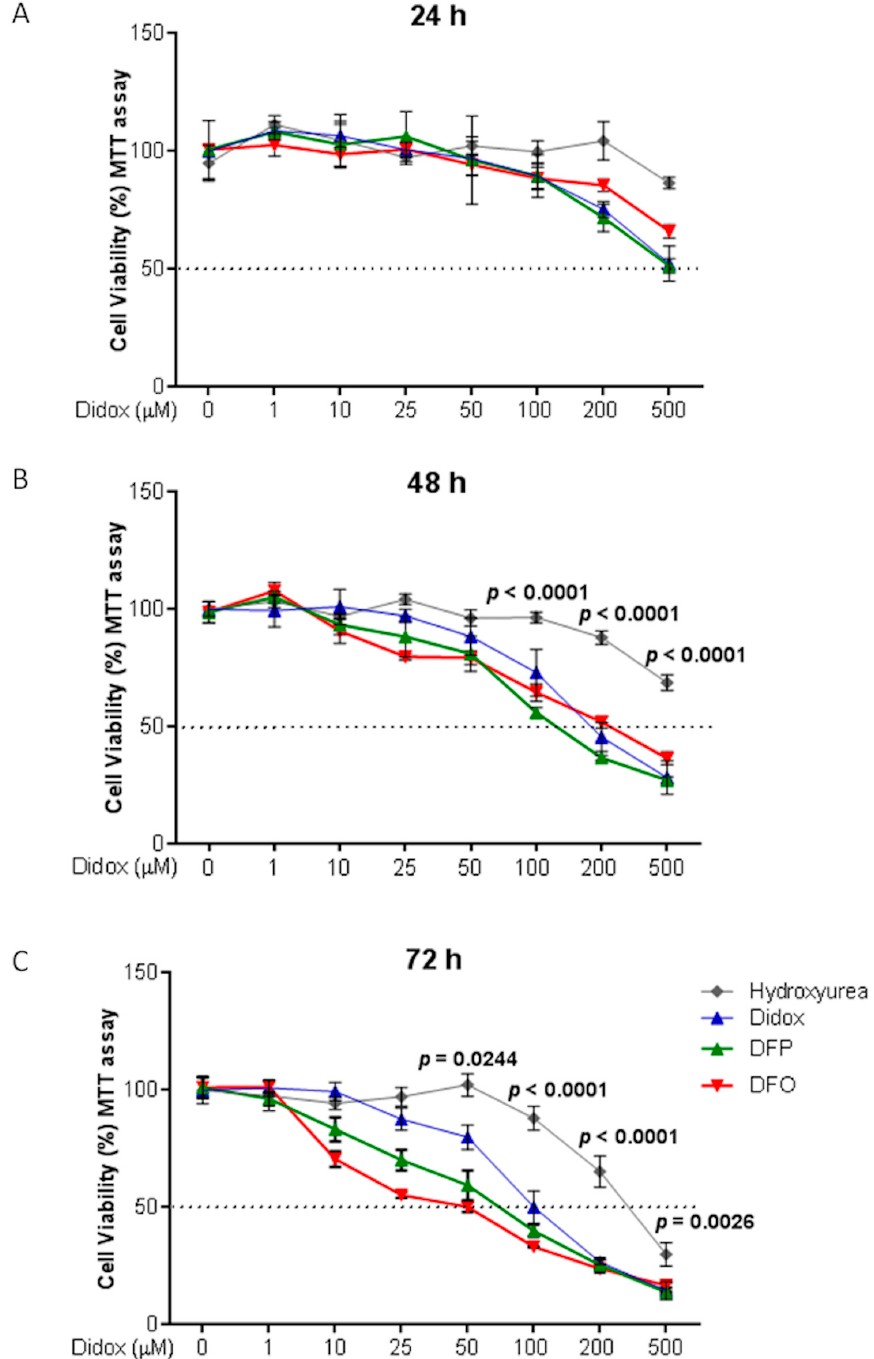
Figure 4. Didox was more effective than hydroxyurea in reducing cell viability in HA22T/VGH. HA22T/VGH cells were treated with 0, 1, 10, 25, 50, 100, 200 and 500 µM of didox (blue lines) or HU (grey lines) or deferoxamine (DFO; red lines) or deferiprone (DFP; green lines) for 24 ( A ), 48 ( B ) and 72 h ( C ). MTT assay was performed to verify cell viability after treatment. The values are expressed as % of viable cells over the not treated cells (0) at the indicated time point. The graphs represent the means of three independent experiments ( N = 3) with three internal values for each experiment and statistic obtained comparing with each other the efficacy of the compounds at a certain dose of treatment. The black dot line is drawn in correspondence to the half maximal inhibitory dose (IC 50 ).